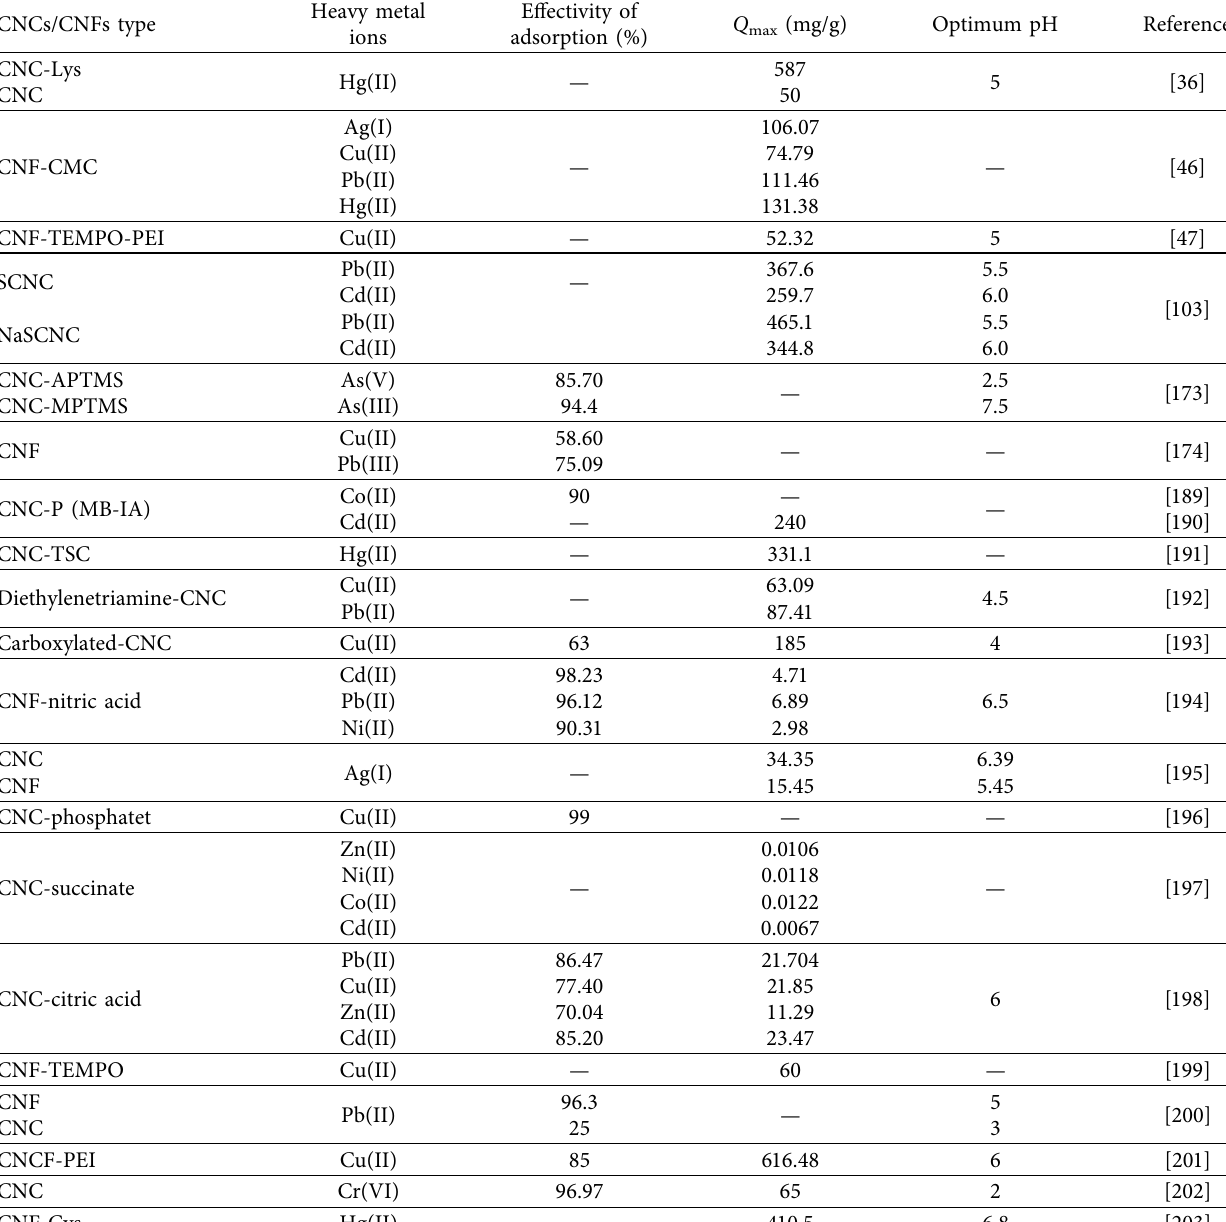
Table 5: Te heavy metal ions adsorption capacity and efectiveness of various modifed CNCs and CNFs at optimum pH. CNCs/CNFs